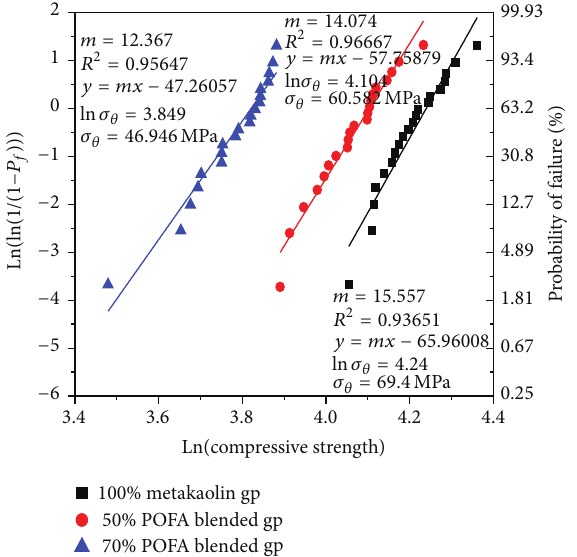
Figure 3: Weibull graph of compressive strength of blended